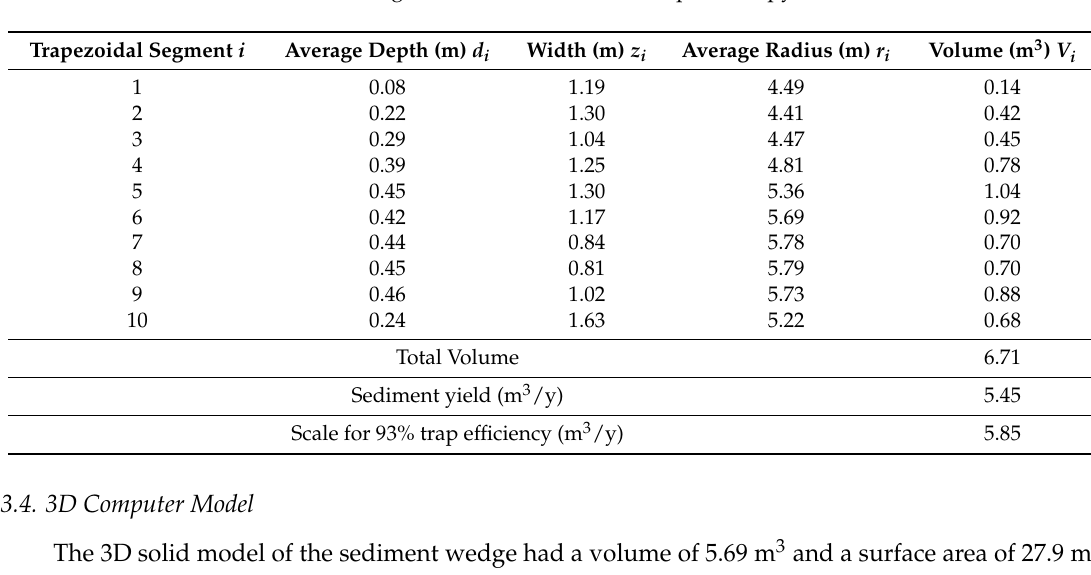
Table 3. Sediment wedge volume calculation for trapezoidal pyramid method.